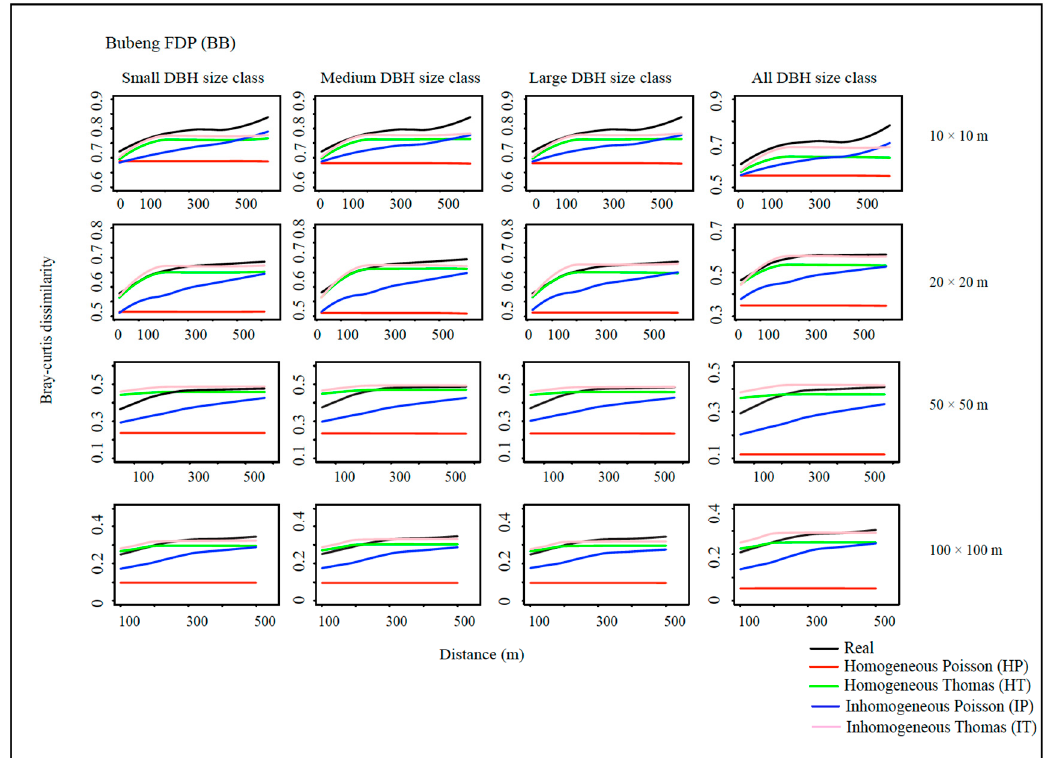
Figure 1. Real and simulated species beta diversity across DBH-size classes at different spatial scales in the Bubeng plot.